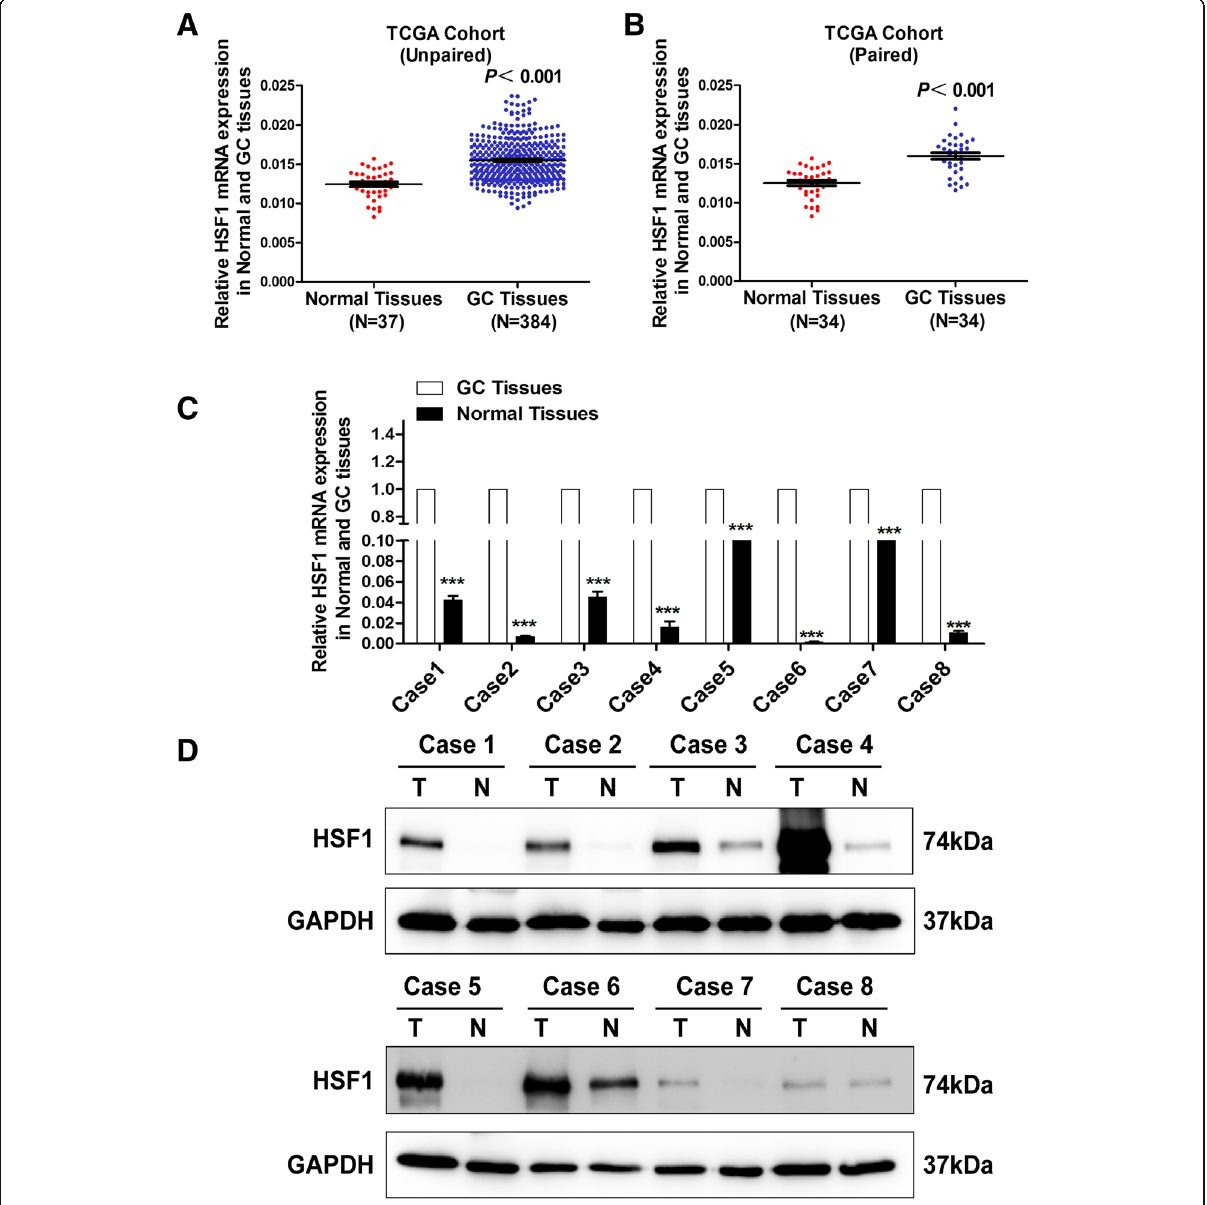
Fig. 1 High HSF1 expression in gastric cancer. ( a ) Analysis of HSF1 expression in unpaired GC ( N = 384) and normal tissues ( N = 37) in the TCGA cohort ( P <0.001); ( b ) HSF1 expression in paired normal and GC tissues ( N = 34) in the TCGA cohort ( P <0.001); ( c ) Expression of HSF1 was analysed by qRT-PCR in paired tumour and normal tissues; ( d ) HSF1 protein levels were measured in GC tissues and respective adjacent non-tumour tissues in 8 typical patients by western